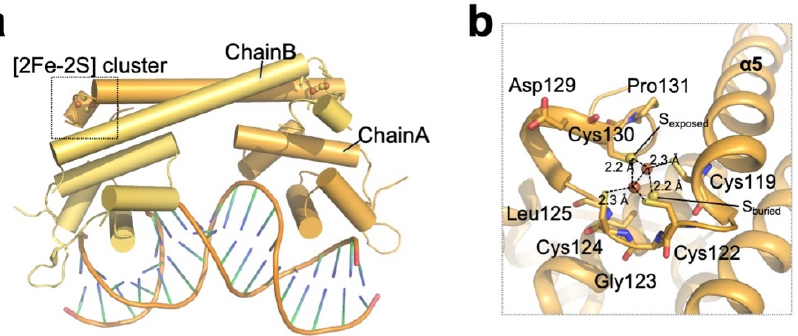
Figure 5. Structure of redox-sensing [2Fe–2S] cluster-containing SoxR. ( a ) Overall structure of the oxidized (activated) E. coli SoxR homodimer (PDB ID: 2ZHG; chain A; orange, chain B; yellow) bound to DNA. ( b ) Close-up view of the [2Fe–2S] cluster of E. coli SoxR chain A. Cysteine residues coordinating the cluster are indicated, and the residues involved in the asymmetric environment are shown as sticks.